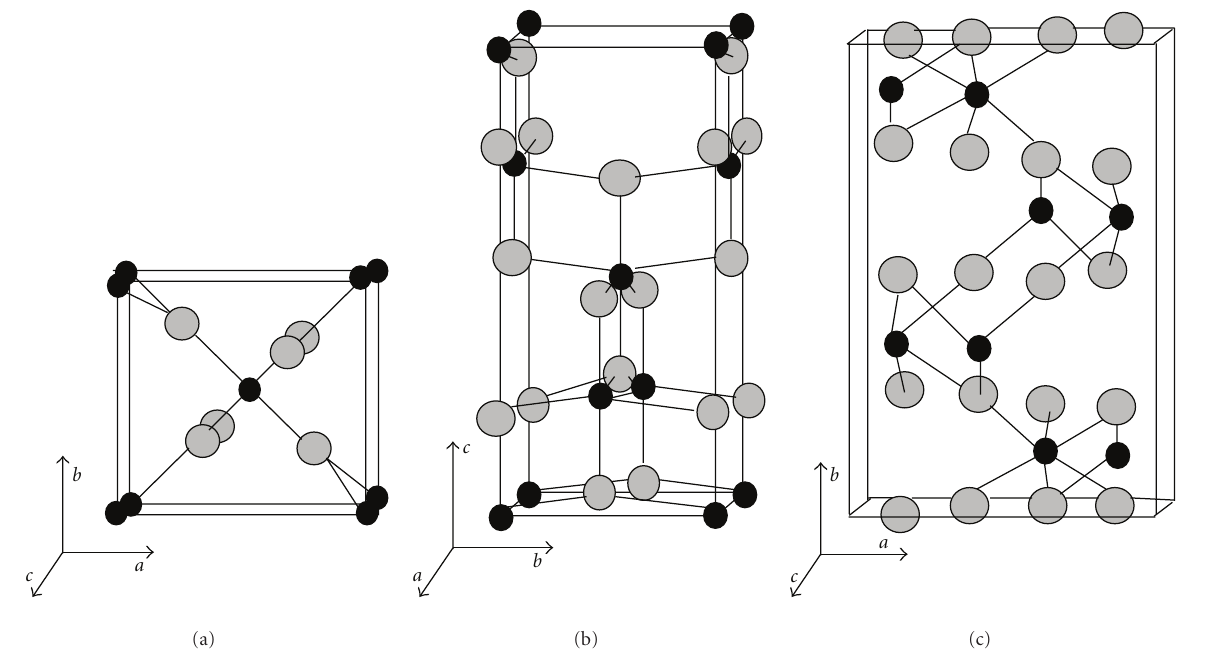
Figure 1: Crystal structures of rutile (a), anatase (b), and brookite (c)